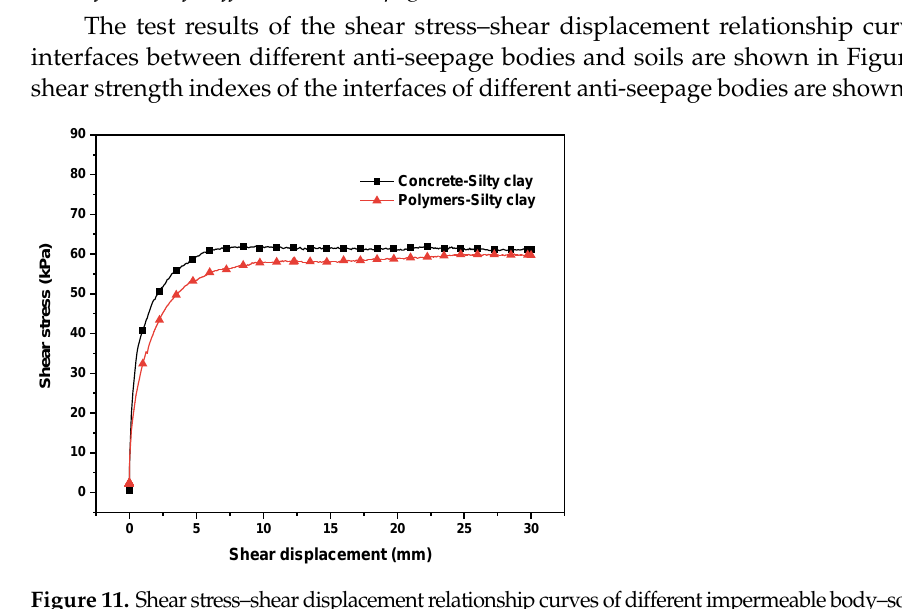
Figure 11. Shearstress–sheardisplacementrelationshipcurvesofdifferentimpermeablebody–soilinterfaces. Table 9. Shear strength indexes of the interfaces of different impermeable